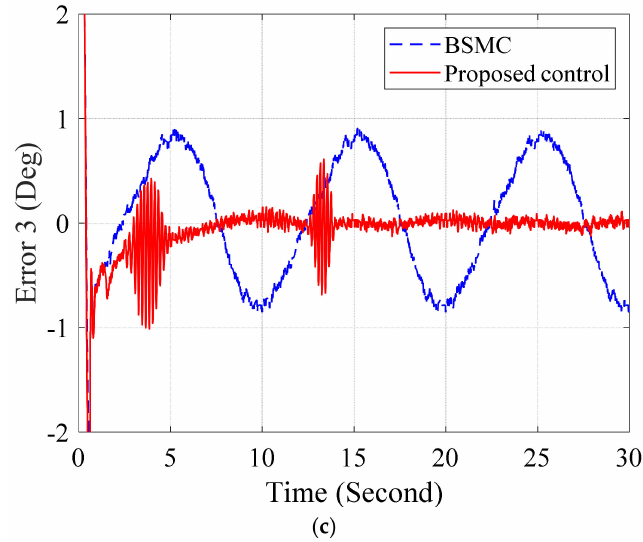
Figure 13. Error responses of BSMC and proposed control in ( a ) joint 1, ( b ) joint 2, and ( c ) joint 3 with load.